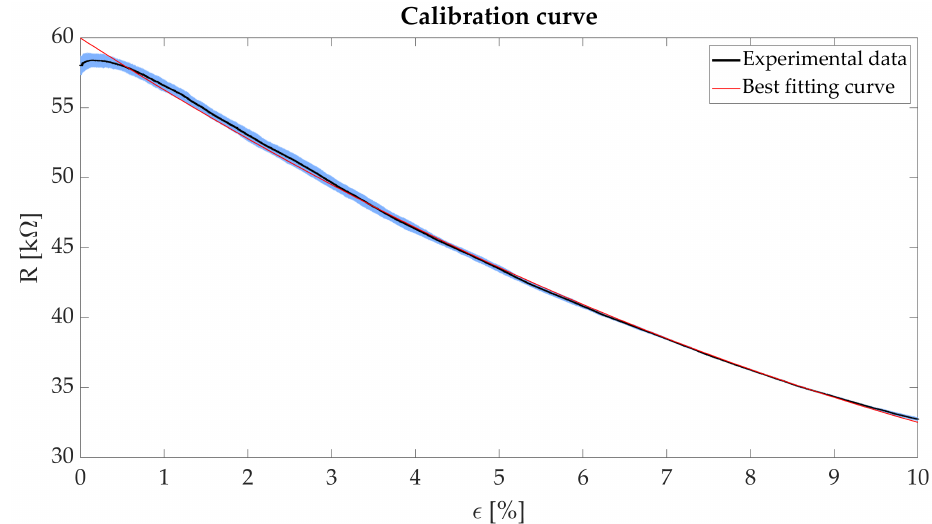
Figure 2. Plot showing the R vs. (cid:101) (black line), its related expanded uncertainty (blue shaded area) and the calculated calibration curve (red